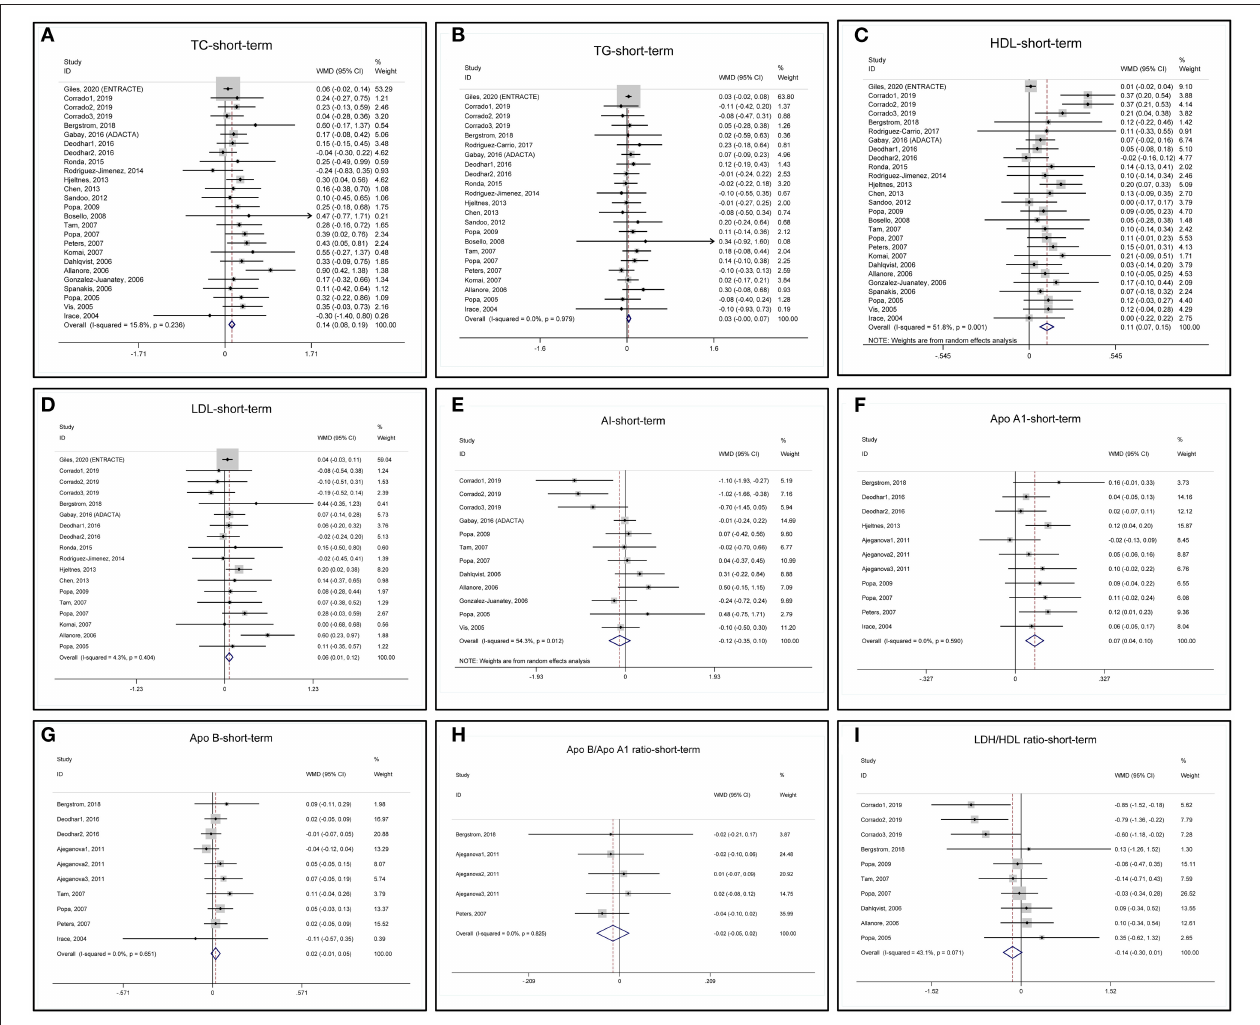
FIGURE 2 | Forest plots of meta-analyses of the short-term changes in (A) total cholesterol (TC), (B) triglyceride (TG), (C) high-density lipoprotein (HDL), (D) low-density lipoprotein (LDL), (E) atherogenic index (AI), (F) ApoA1, (G) ApoB, (H) ApoB/ApoA1 ratio, and (I) LDL/HDL